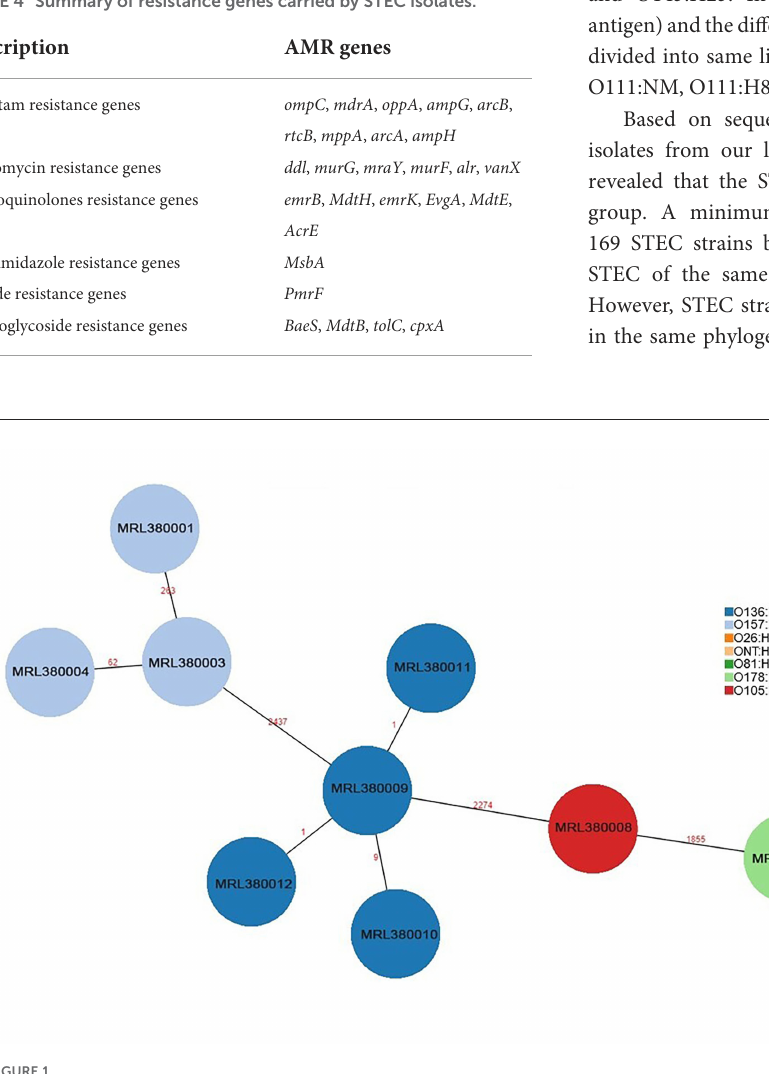
FIGURE1 Minimum spanning tree for 12 STEC isolates from 289 samples based on the 2,514 loci, a total of 7 serotypes, different colors represent different